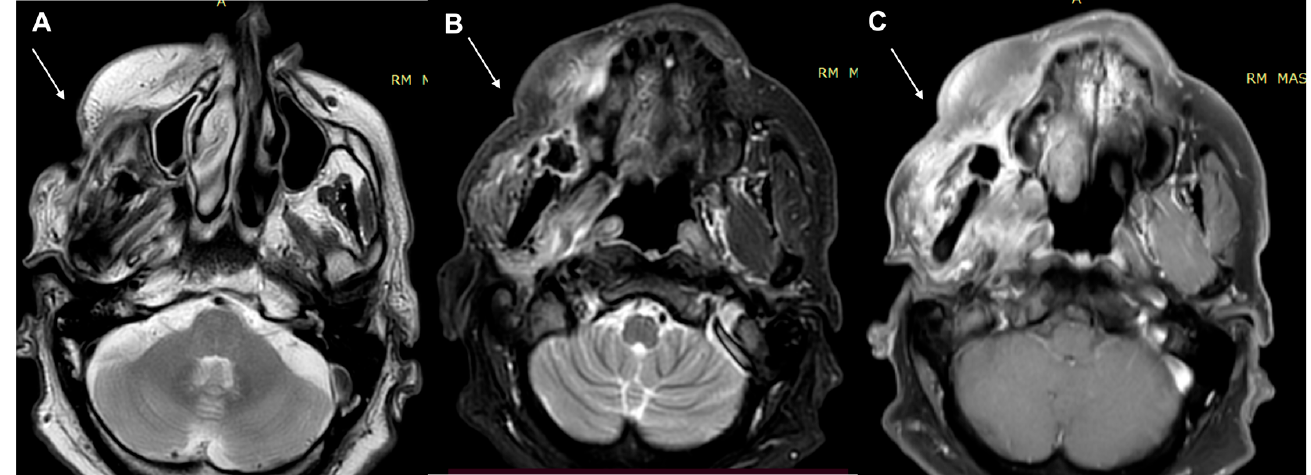
Figure 7. A 53-year-old female patient, MRI examination. ( A ) Enhanced MRI imaging: T2 weighted imaging. ( B ) T2 weighted imaging fat sat. ( C ) Enhanced MRI imaging. The lesion shows high intensity reinforcement in the contrast-enhanced study image ( C ) and bone involvement.